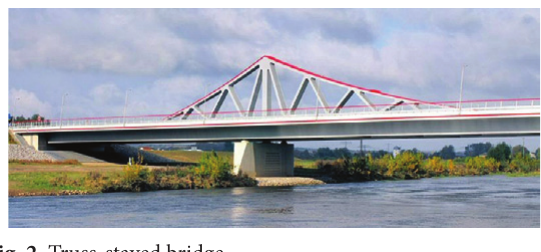
Fig. 2. Truss-stayed bridge Fig. 3. Cable-stayed bridge with trussed